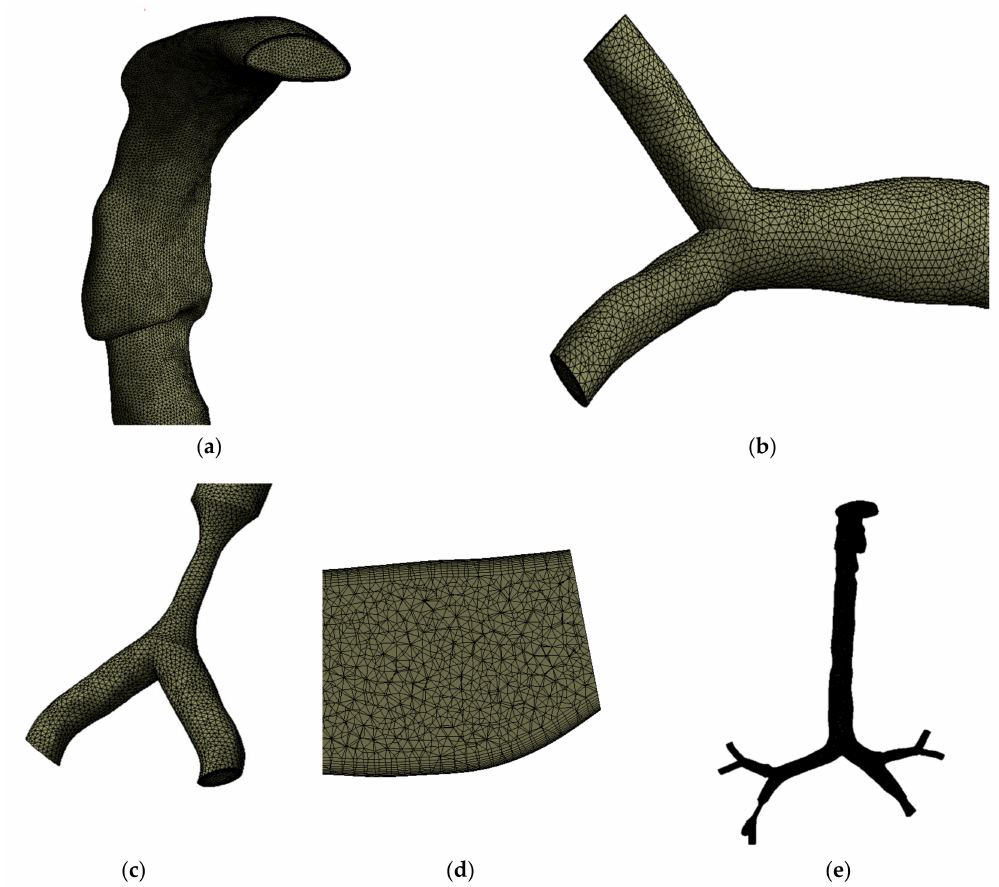
Figure 2. Unstructured mesh for the model, ( a ) the mouth–throat, ( b ) the mesh at a bifurcating branch, ( c ) the mesh at the stenosis area, ( d ) a cross section of the inflation layer mesh, and ( e ) the complete computational